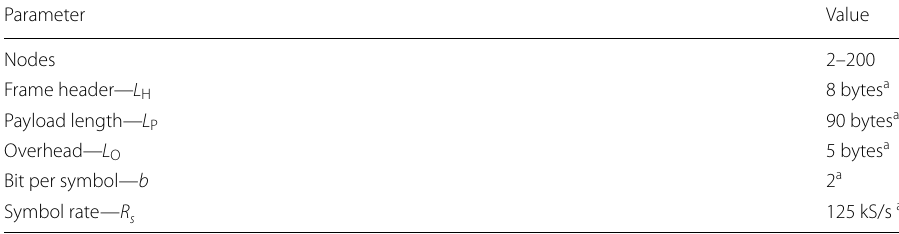
Table 1 Parameters used for ns-3